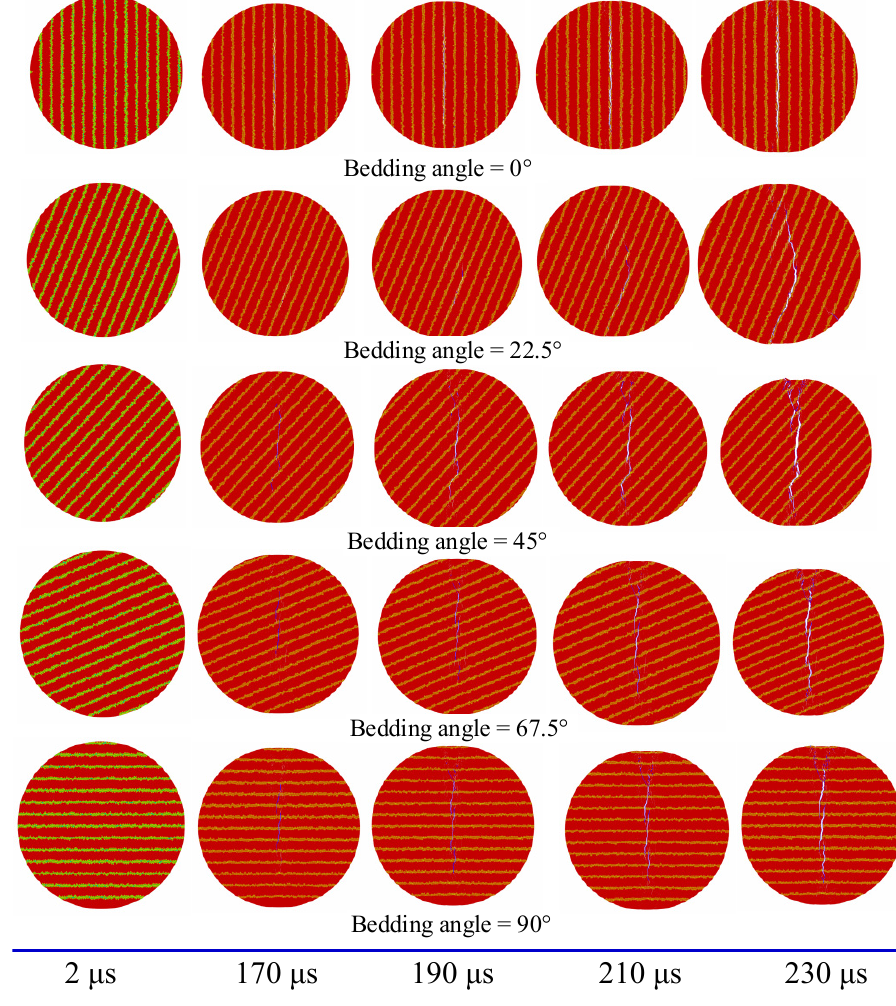
Figure 26. Dynamic crack initiation process.